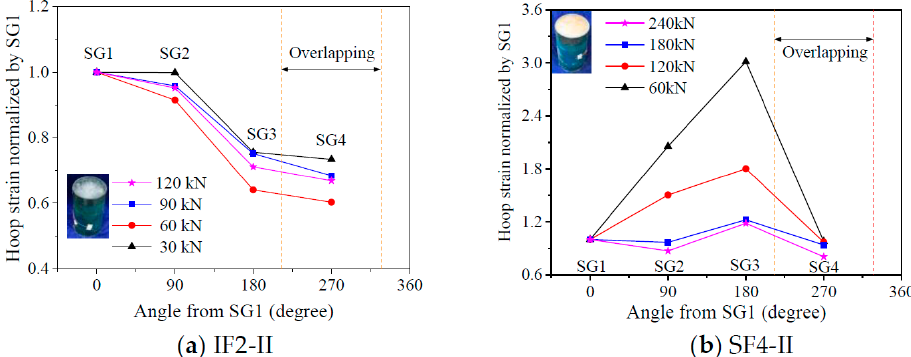
Figure 13. Distribution of normalized hoop strains of FRP tubes in PIFFT and SIFFT specimens at different loads.